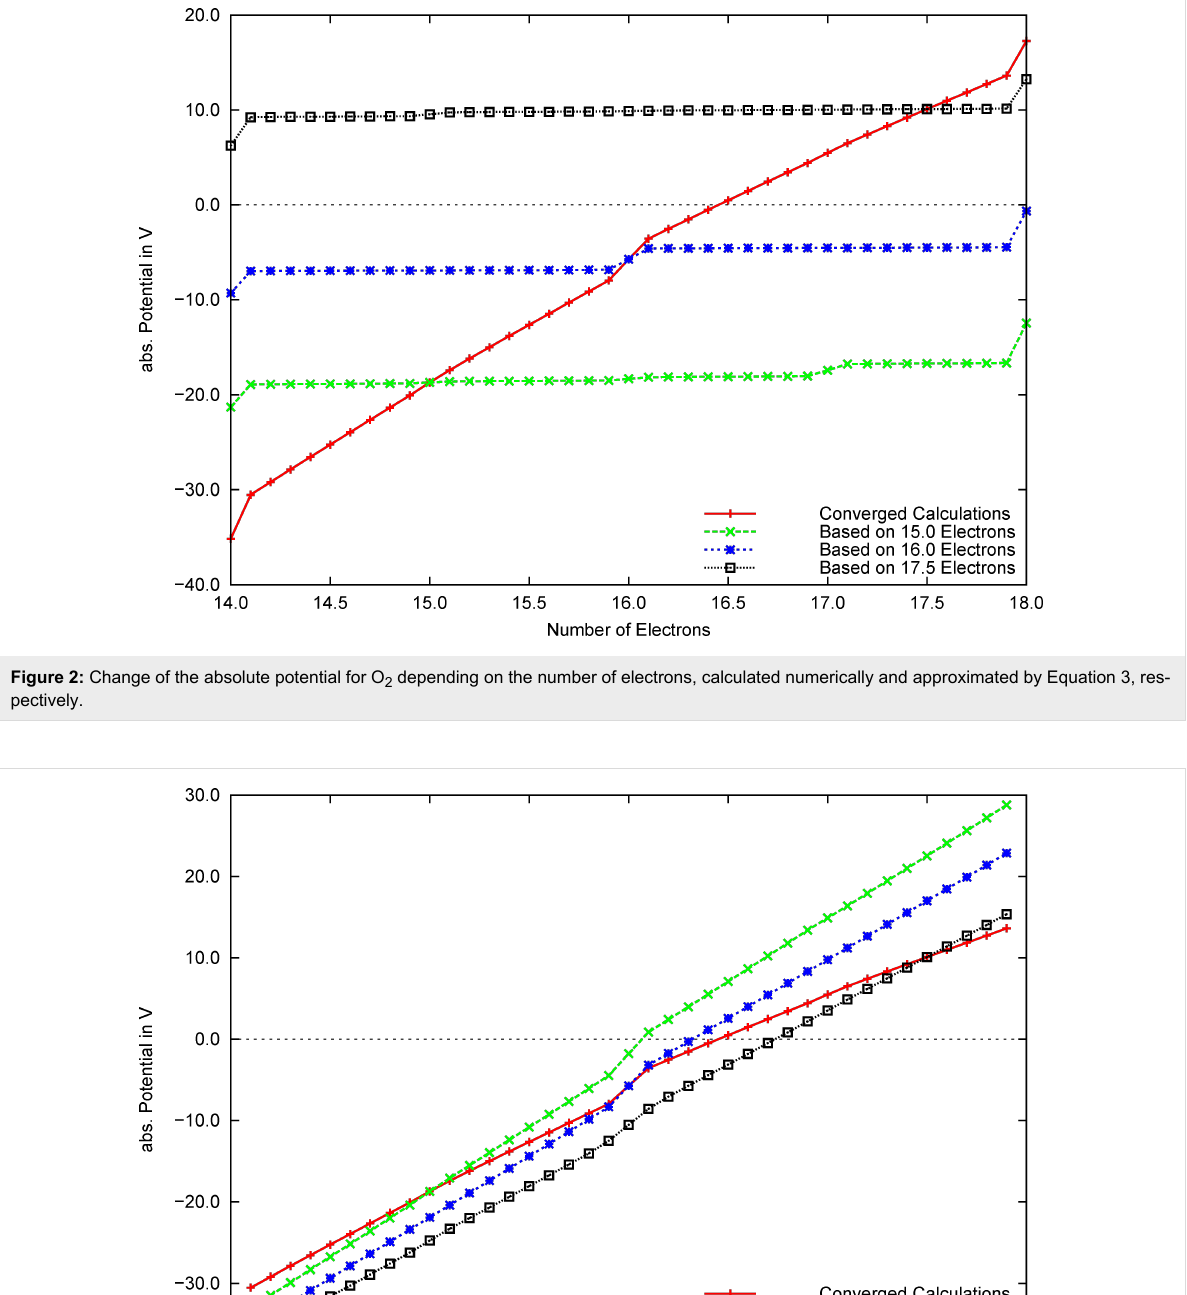
tions using a fractional N . Using the MO coefficients of the converged calculations with a N of 15.0, 16.0 and 17.5 elec- trons, approximated energies were calculated by using Equa-